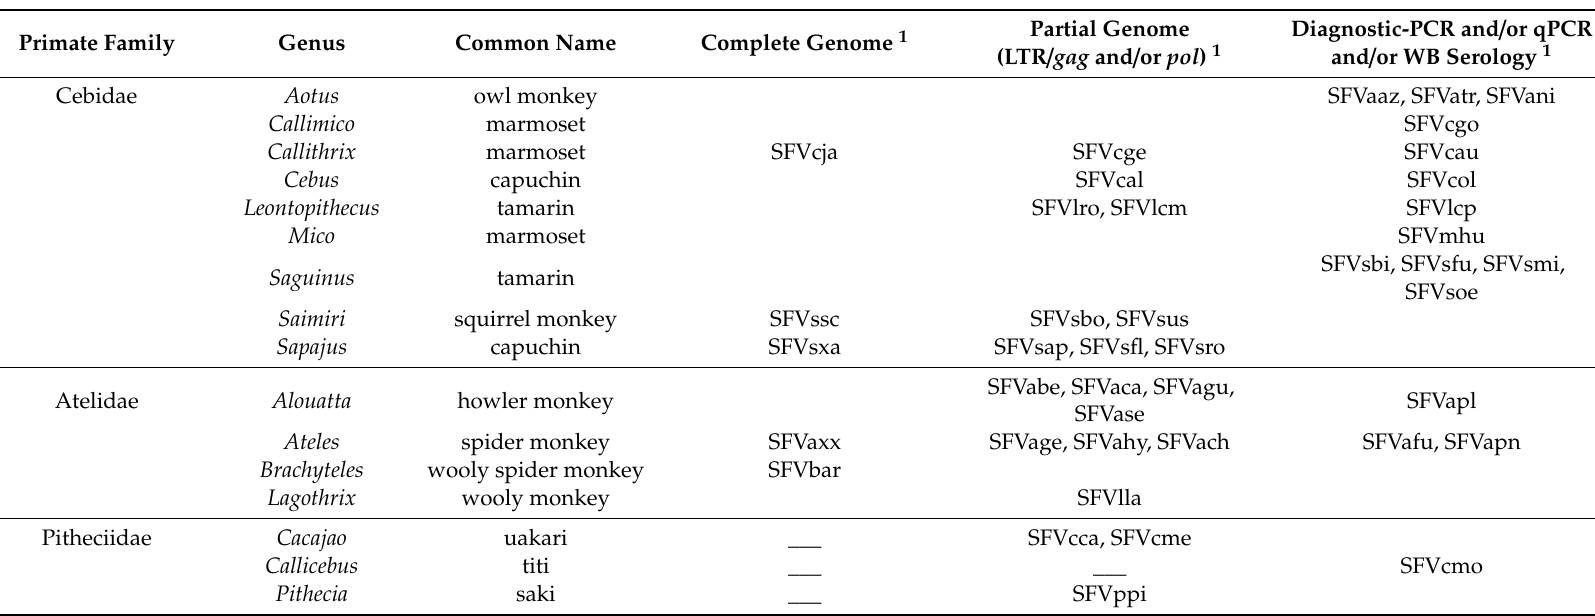
Table 1. Simian foamy virus (SFV) diversity in neotropical primates revealed by virus detection and complete or partial genome